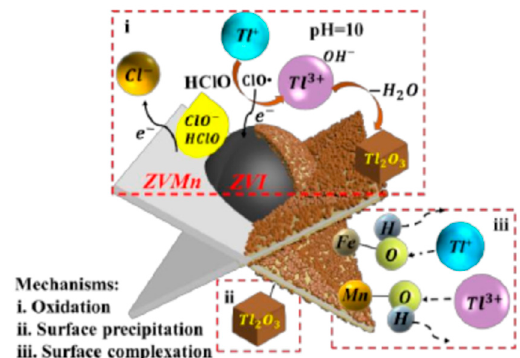
Figure 3. Mechanism of adsorption of thallium by 3-ZVIMn adsorbent [59].